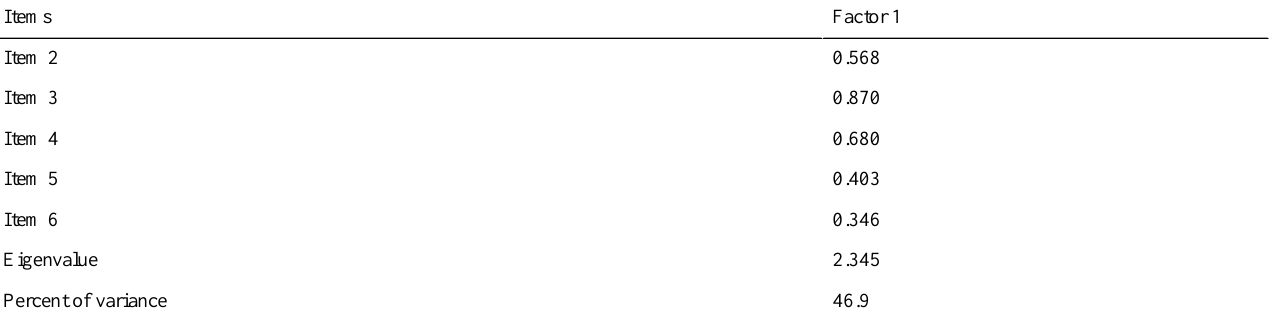
Table 3. Factor matrix containing obliquely unrotated factor loadings of principal axis factoring (forcing one-factor solution). The eigenvalue and the percentage of variance explained by the factor are also shown.